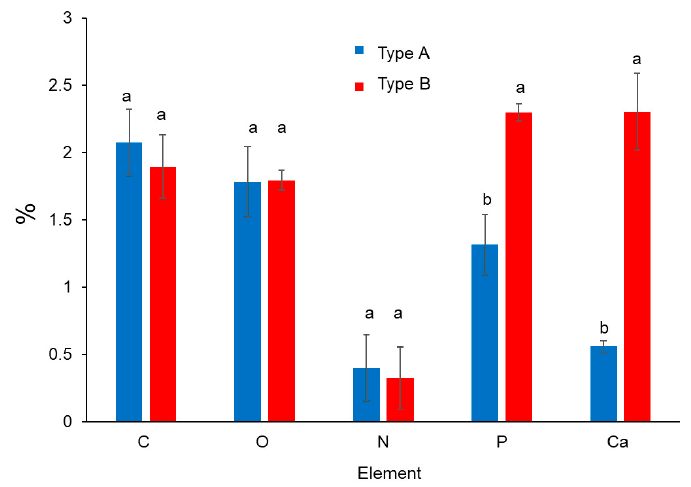
Figure 1. Organic components of proteins (C, O, N) and minerals (P, Ca) of deposits type A and B on SSP plates.